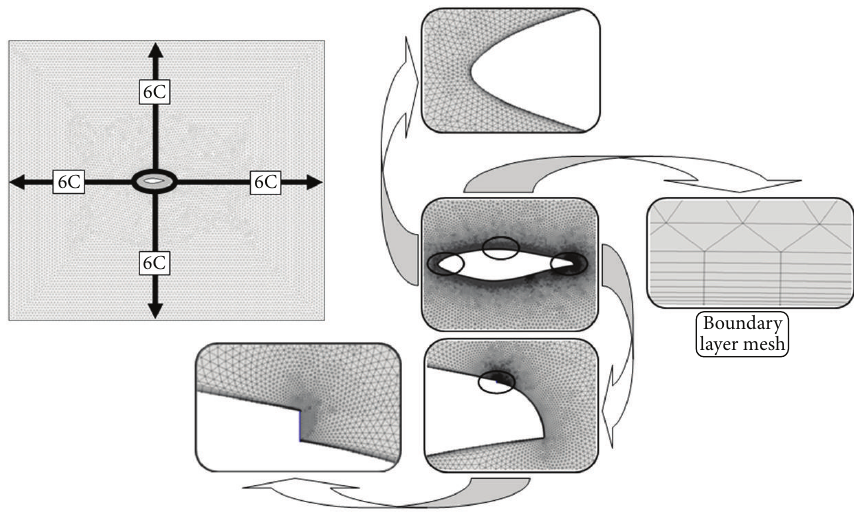
Figure 5: Computational grid around a typical airfoil, shown here for S809 Coand˘a configured